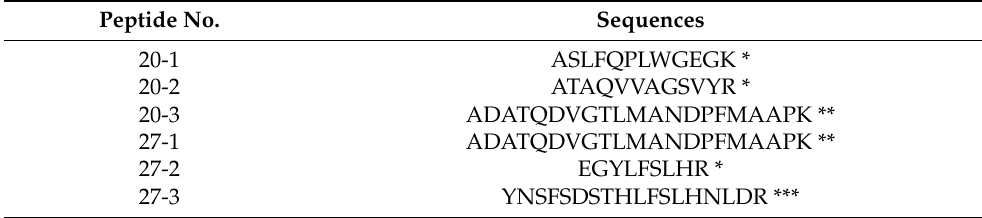
Table 1. Partial amino acid sequences of the two isolated proteins with CPI activity. Peptide